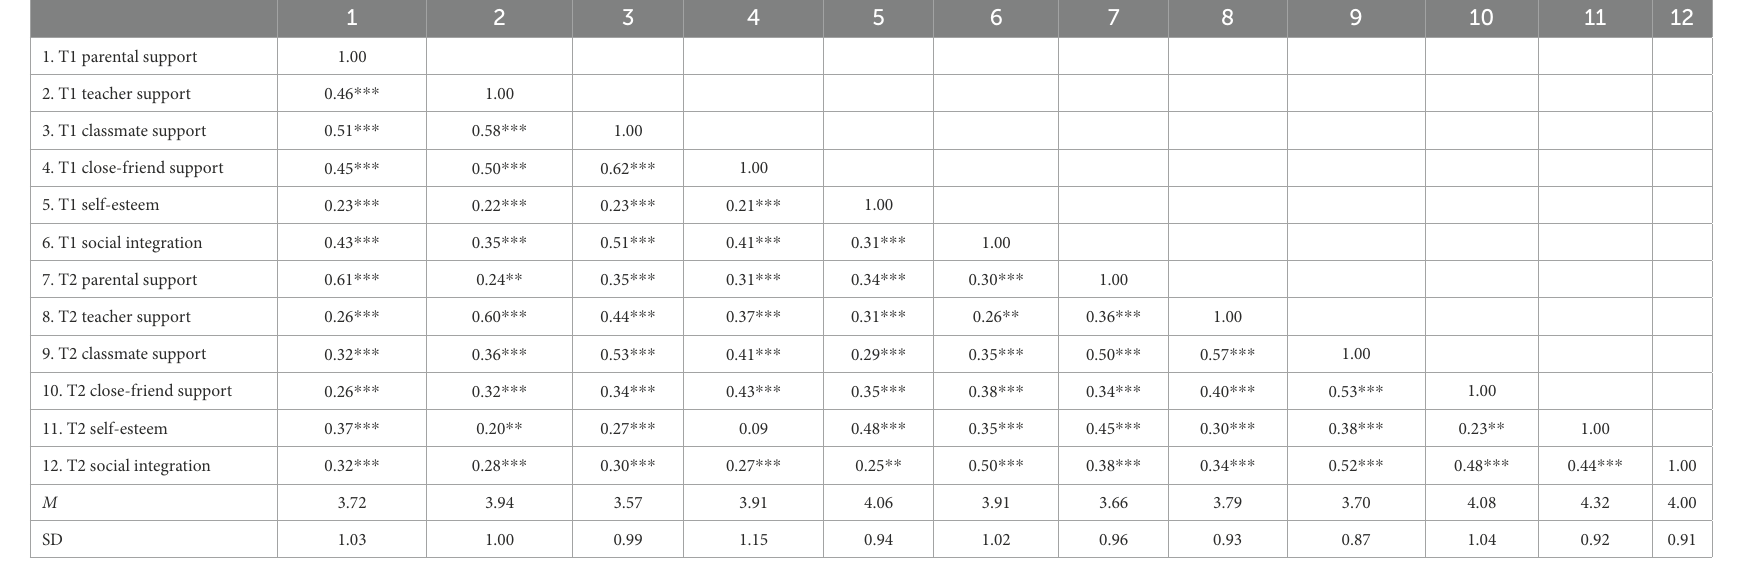
TABLE 3 Descriptive statistics and zero-order correlations among perceived social support, self-esteem, and social